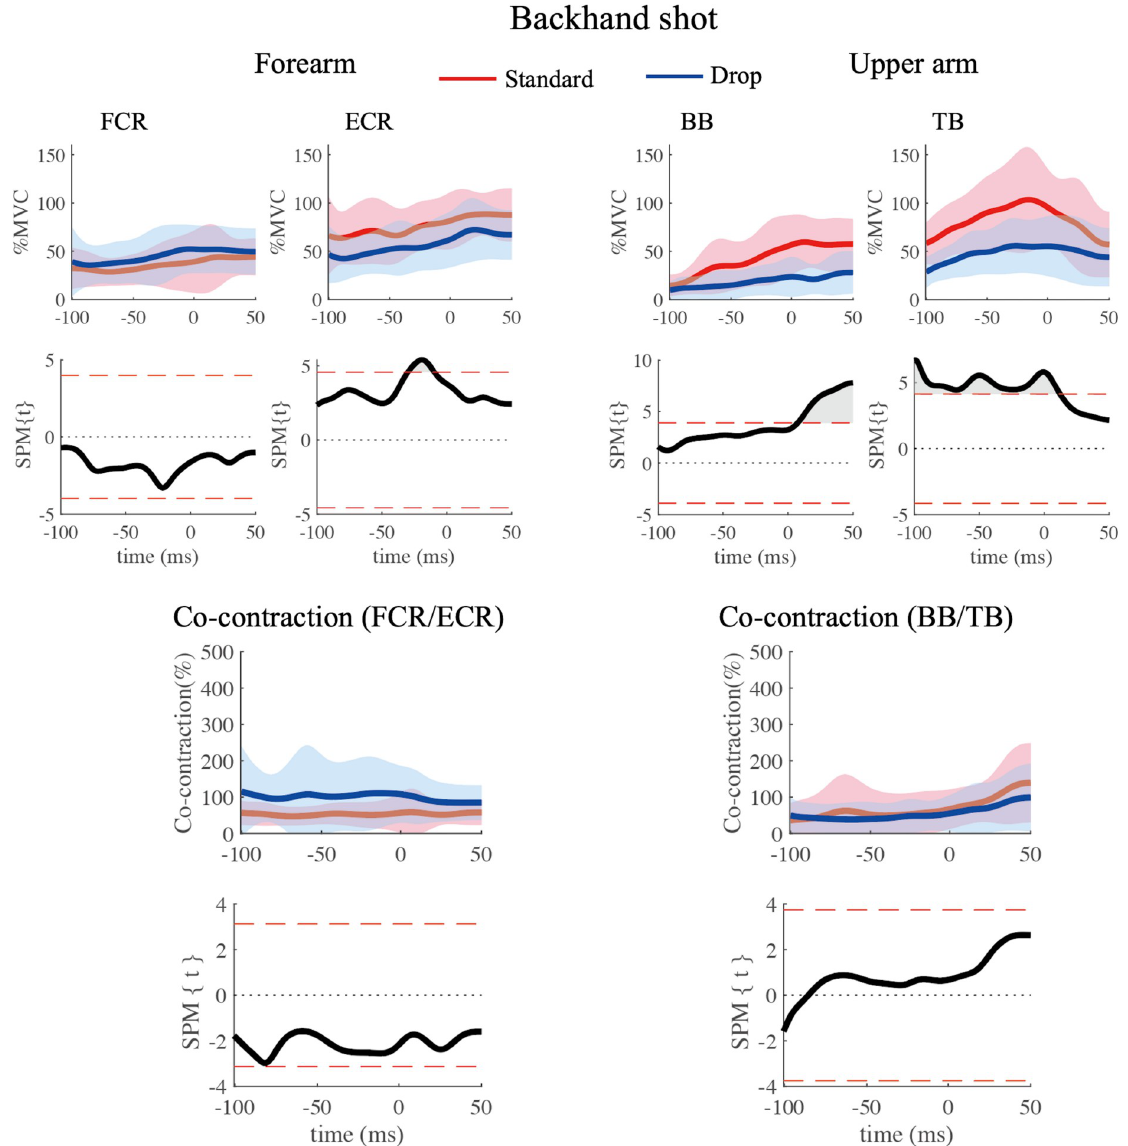
Fig 8. Four muscle activity comparing the standard volley (red lines) and the drop volley (blue lines) for the backhand shot. Averaged time series data were presented with corresponding results of the SPM analysis. Gray areas indicate the times when SPM{t} values exceeded the alpha level threshold, which is displayed as red dash lines. Time 0 depicts of the time of